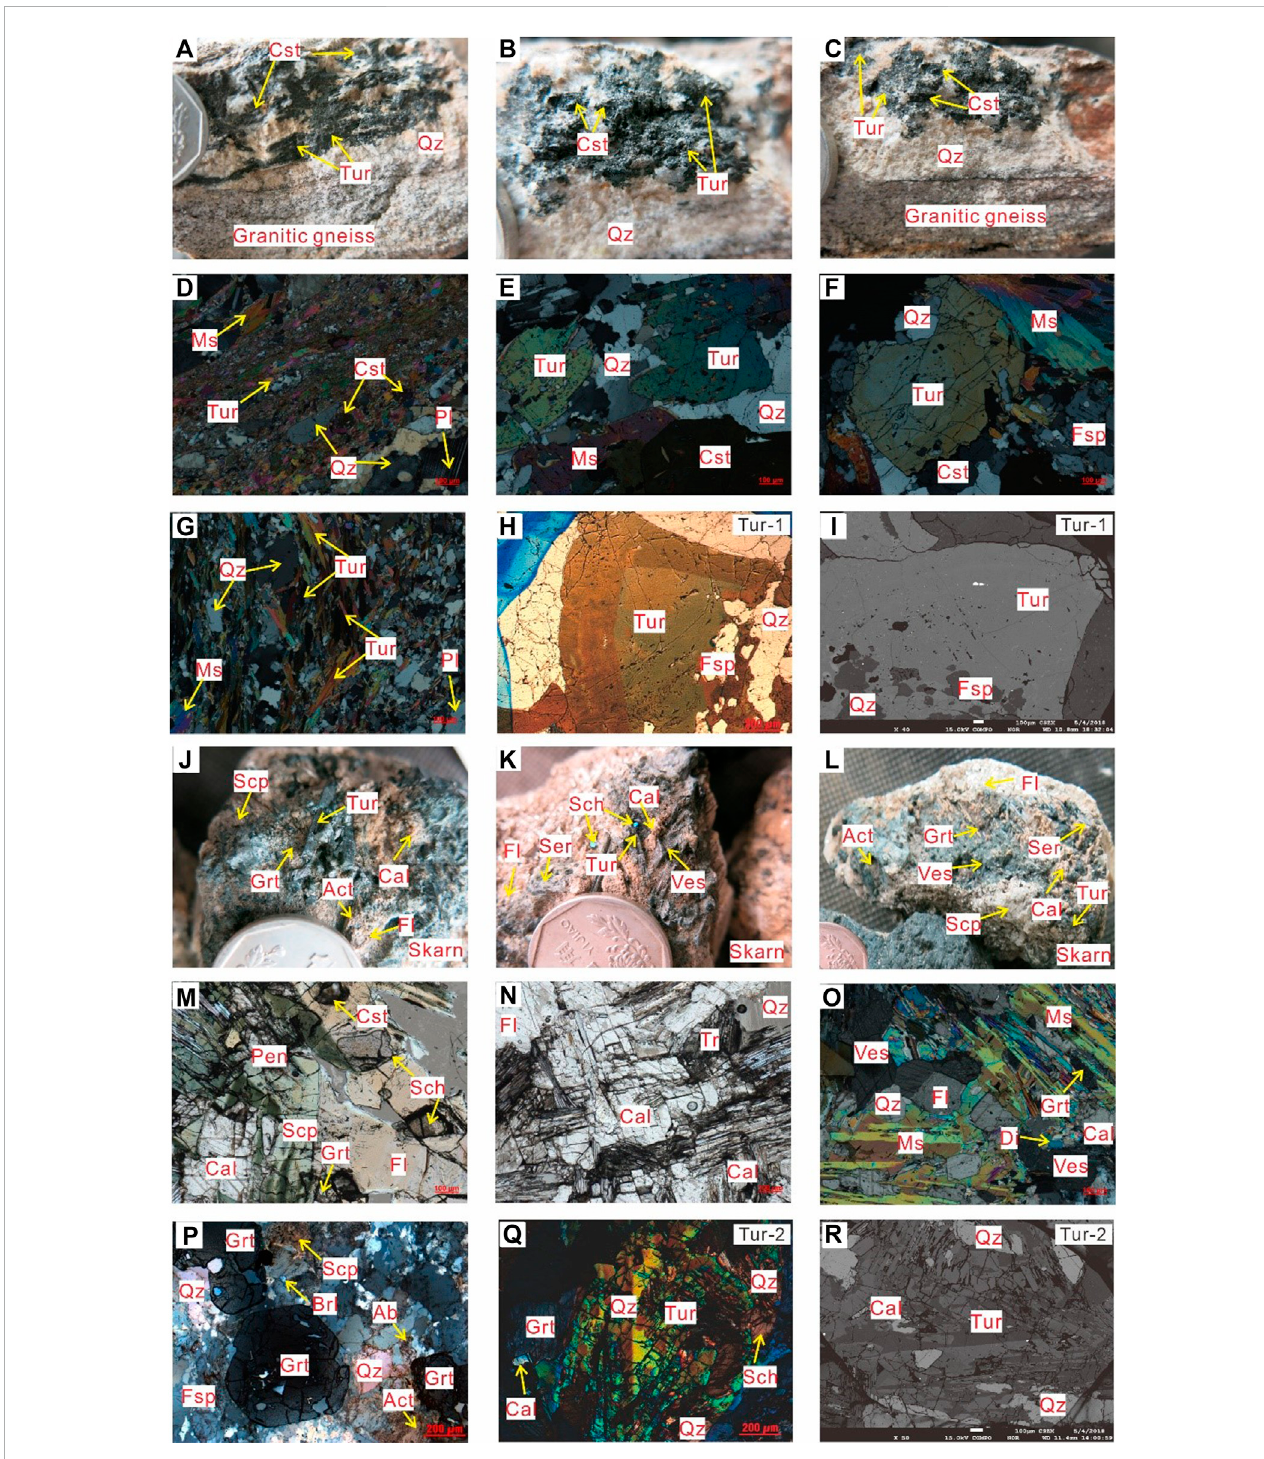
FIGURE 2 Hand specimens, photomicrographs, and backscattered electron images of rocks in the hydrothermal quartz vein (A – I) and skarn (J – R) from the Cuonadong Sn – W – Be polymetallic deposit. (A) Cassiterite-bearing quartz vein, with unconformity of the granitic gneiss. (B) Cassiterite-bearing quartz vein with tourmaline, cassiterite, and quartz. (C) Cassiterite-bearing quartz vein with unconformity contacting the granitic gneiss. (D) Tourmaline, cassiterite, muscovite, plagioclase, and quartz in the hydrothermal quartz vein. (E) Tourmaline, cassiterite, muscovite, plagioclase, and quartz in the hydrothermal quartz vein. (F) Tourmaline, cassiterite, muscovite, feldspar, and quartz in the cassiterite-bearing quartz vein. (G) Tourmaline, muscovite, plagioclase, and quartzinthecassiterite-bearingquartzvein. (H – I) Tourmalineinthecassiterite-bearingquartzvein(Tur-1)withasubhedralstructureandmineralinclusionsin the photomicrograph and backscattered electron image. (J) Scapolite, calcite, garnet, fl uorite, actinolite, and tourmaline in the skarn. (K) Scheelite, tourmaline, sericite, fl uorite, calcite, and vesuvianite in the skarn under ultraviolet light. (L) Scapolite, tourmaline, sericite, fl uorite, calcite, actinolite, and vesuvianite in skarn. (M) Calcite, garnet, fl uorite, penninite, scheelite, scapolite, and cassiterite in the skarn. (N) Calcite, fl uorite, tremolite, and quartz in the skarn. (O) Calcite,garnet, fl uorite,vesuvianite, diopside,quartz,andmuscoviteintheskarn. (P)